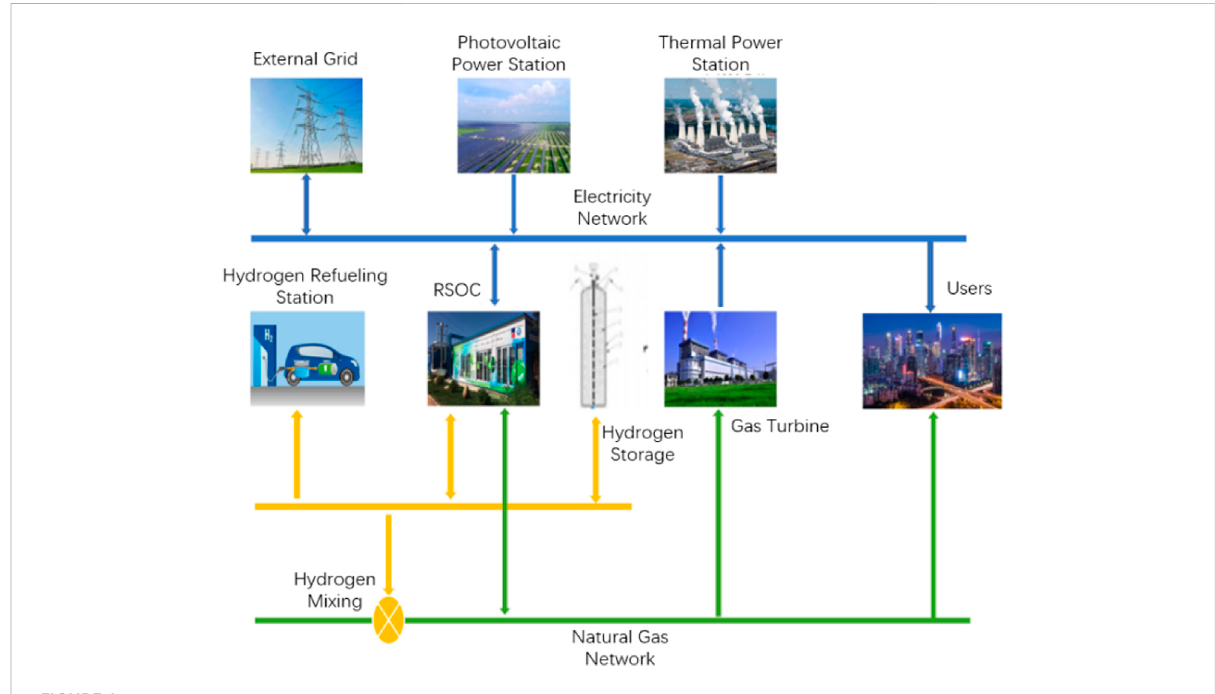
FIGURE 1 The IEGS including RSOC and H 2